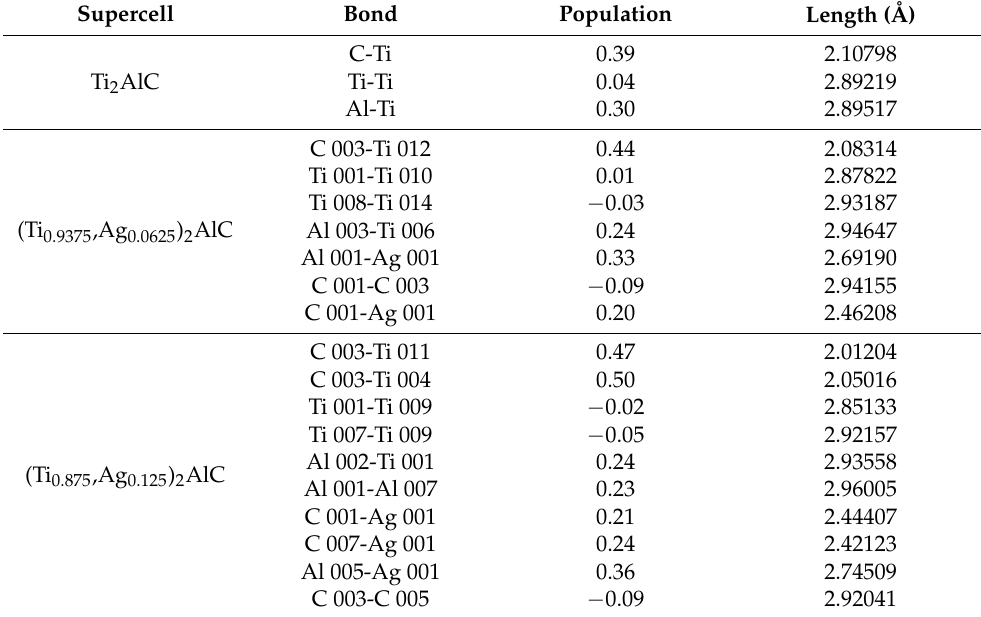
Table 5. Mulliken bond overlap populations of the Ti 2 AlC and (Ti 1 − y ,Ag y ) 2 AlC supercells. Supercell Bond Population Length